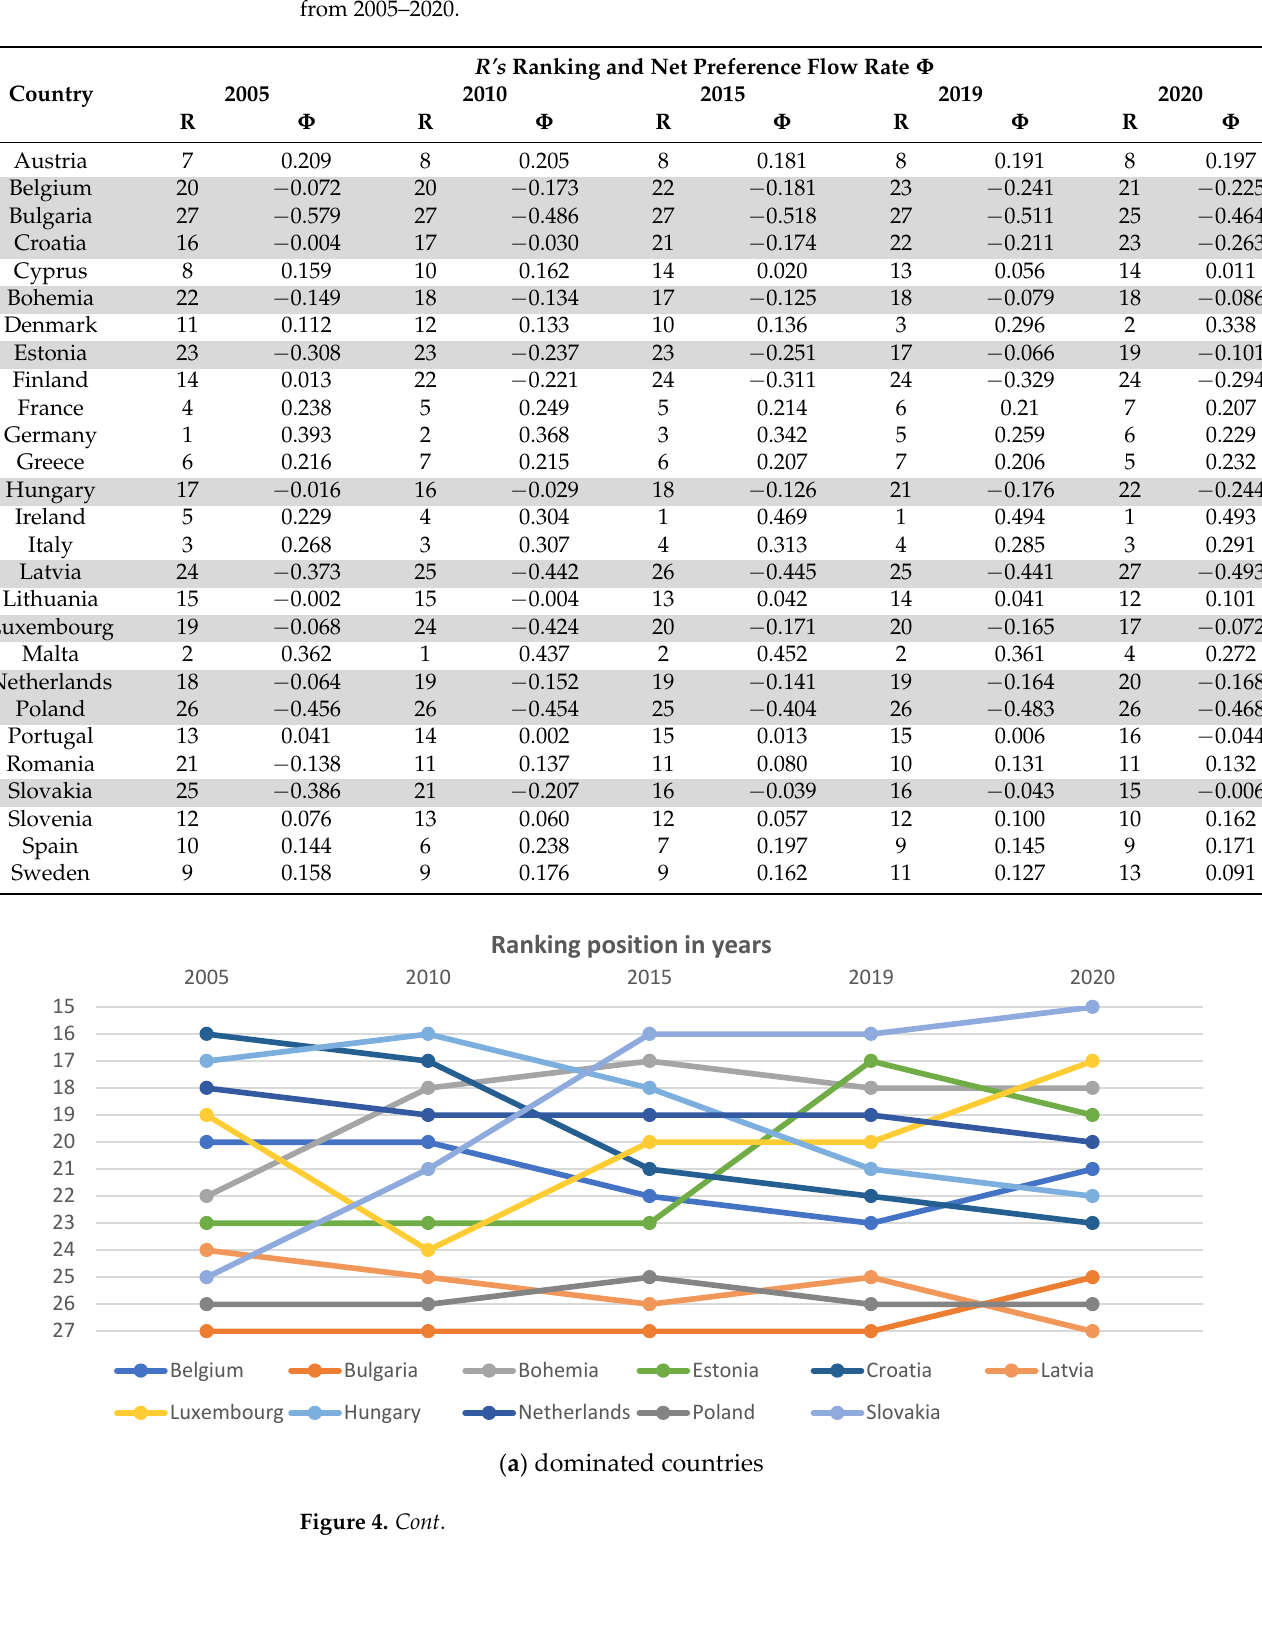
Table 6. Country rankings in energy intensity by economic sector for the years selected for the study from 2005–2020.